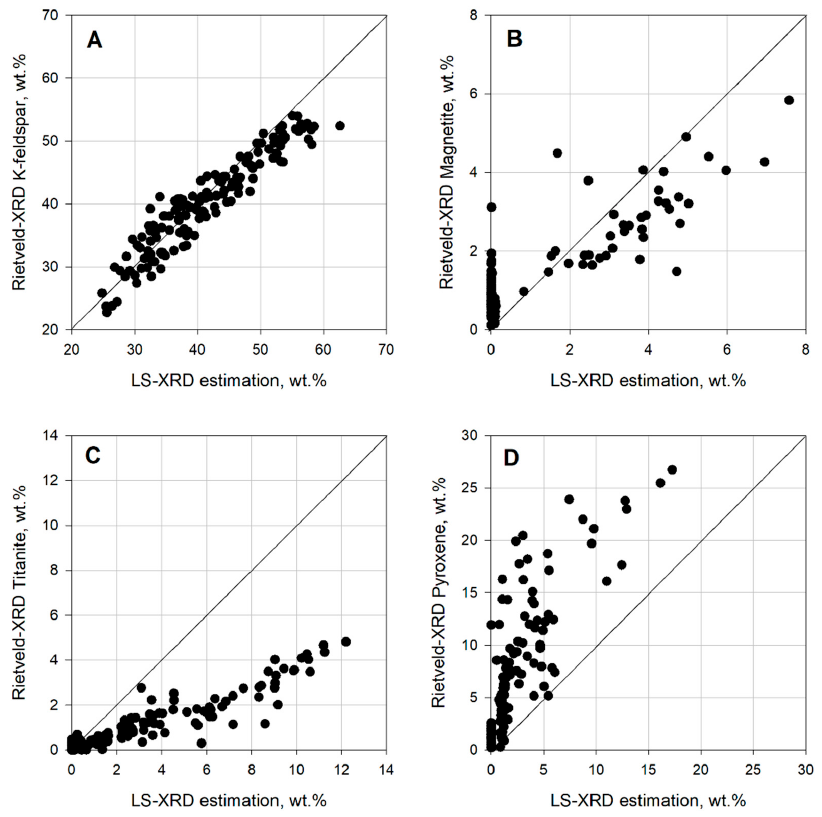
Figure 5. Comparison between LS-XRD estimation ( x -axis) and measured ( y -axis) K-feldspar ( A ); magnetite ( B ); titanite ( C ); and pyroxene ( D